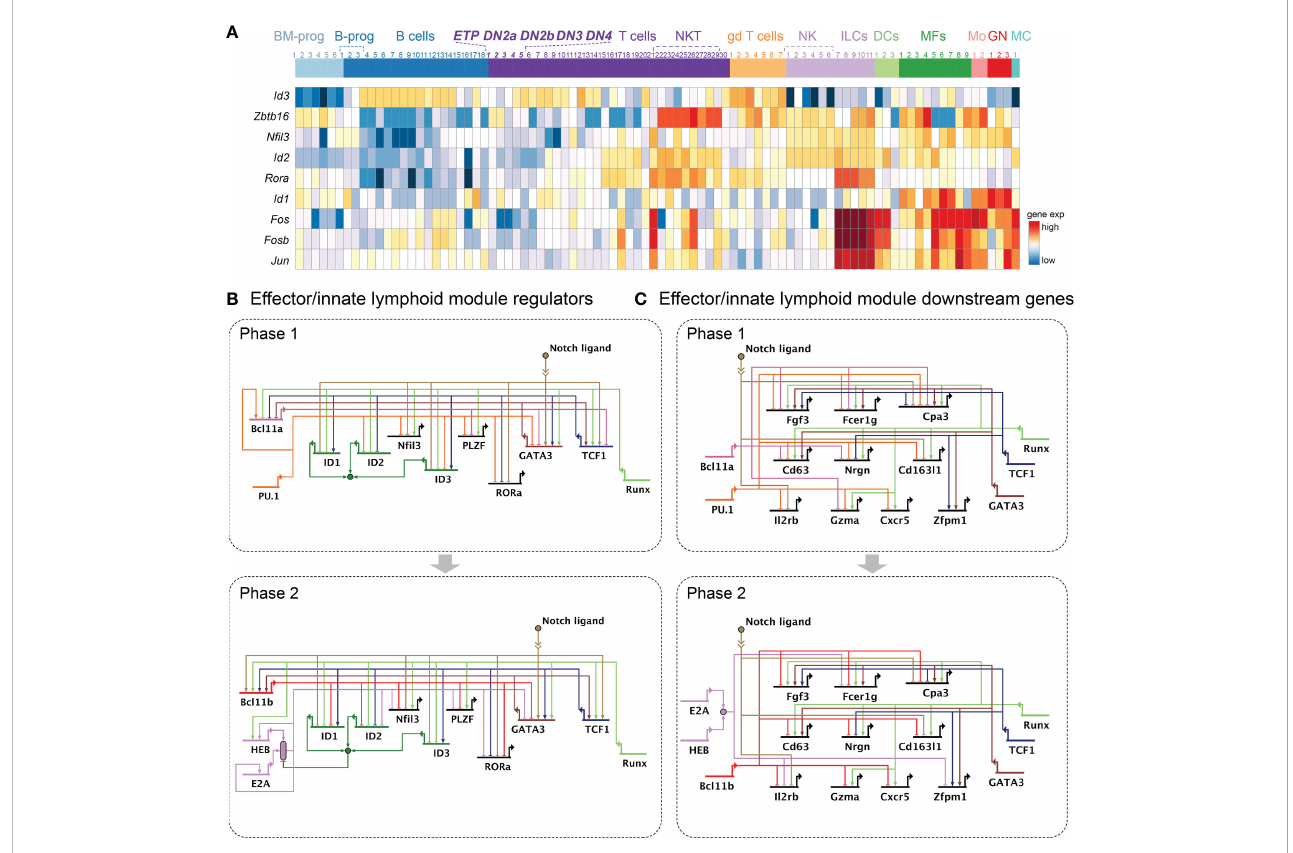
FIGURE 5 Gene regulatory networks regulating the effector or innate lymphoid module. (A) Heatmap represents expression patterns of transcription factors supporting the effector or innate lymphoid module. Heatmap shows the same immune cell populations displayed in Figure 2A. (B, C). Gene regulatory network models as in Figure 2. (B) Current model for transcription factors regulating the effector or innate lymphoid module in Phase 1 (top) and Phase 2 (bottom). (C) Current model for the effector or innate lymphoid module downstream molecules in Phase 1 (top) and Phase 2 (bottom). Growth factor, immunoglobulin, scavenger, or chemokine receptors ( Fgf3, Fcer1g, Cd163l1, Il2rb, Cxcr5 ), enzymes ( Cpa, Gzma ), and signal transduction associated molecules ( Cd63, Nrgn ) involved in immune cell effector function and innate lymphoid cells are shown. Not all genes discussed in the text are